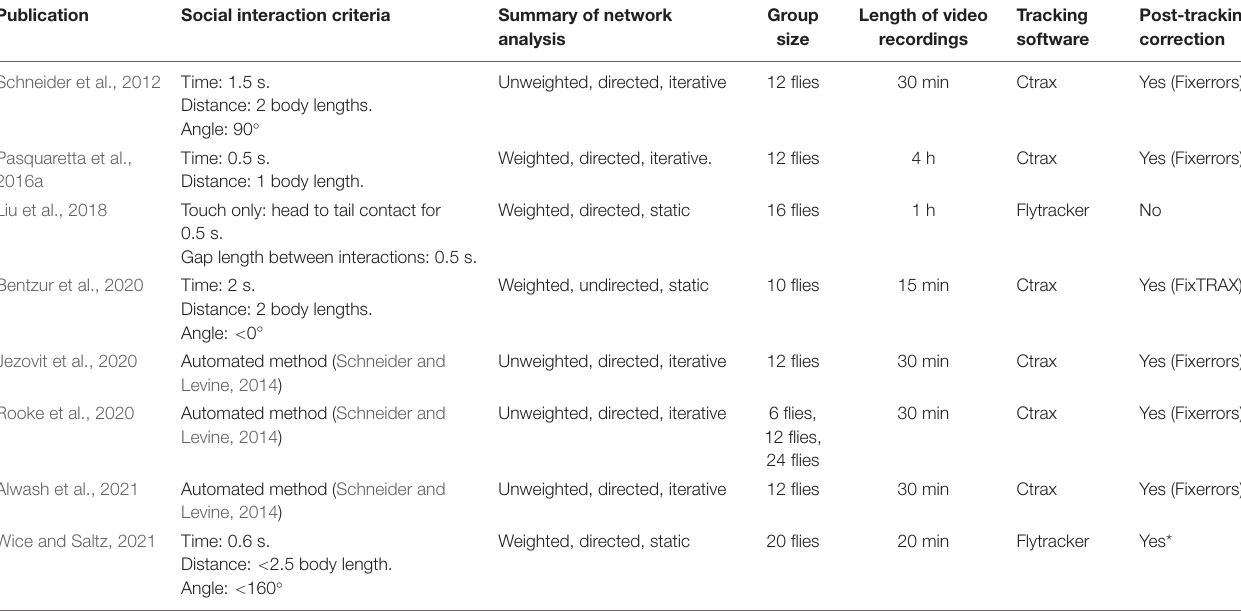
TABLE 2 | A comparison of all published-to-date Drosophila social network studies with their network analysis methods